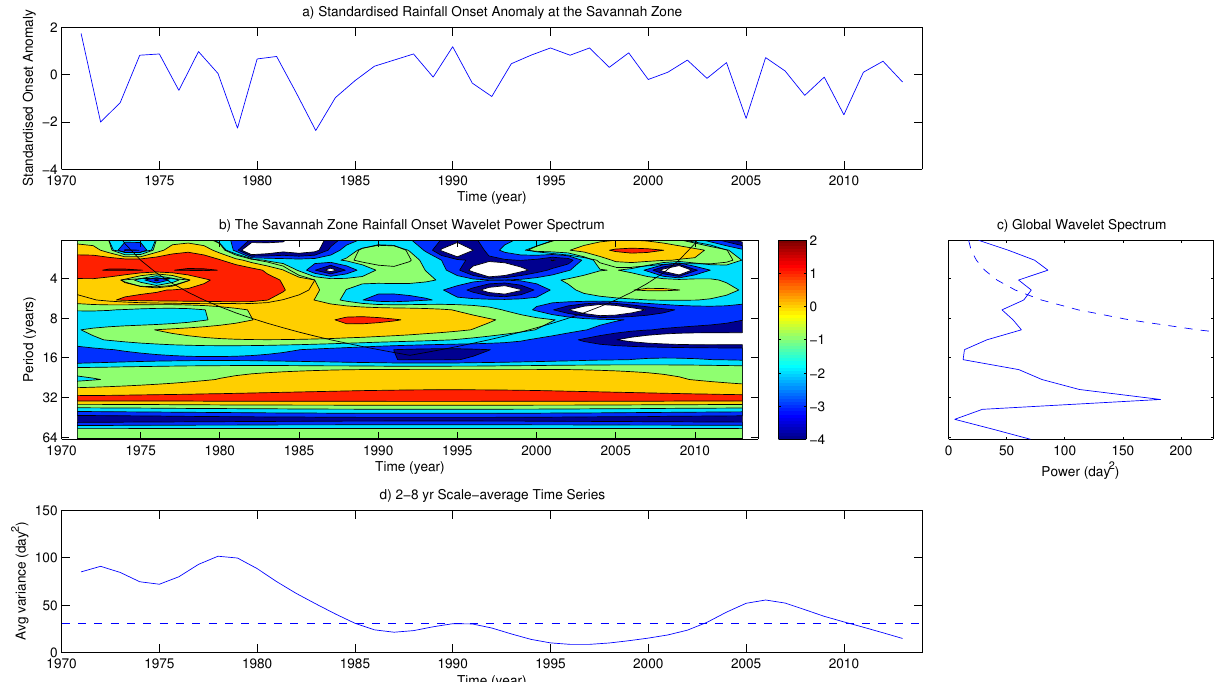
Figure 6. Inter annual variability of rainfall onset dates for the savannah zone using wavelet analysis. ( a ) Standardized anomaly of onset dates; ( b ) wavelet power spectrum; ( c ) the global wavelet power spectrum; the dashed line is the 5% significance level for the global wavelet spectrum; ( d ) the scaled average wavelet power over the 2–8-year band for the onset; the dashed line shows is the 95% confidence